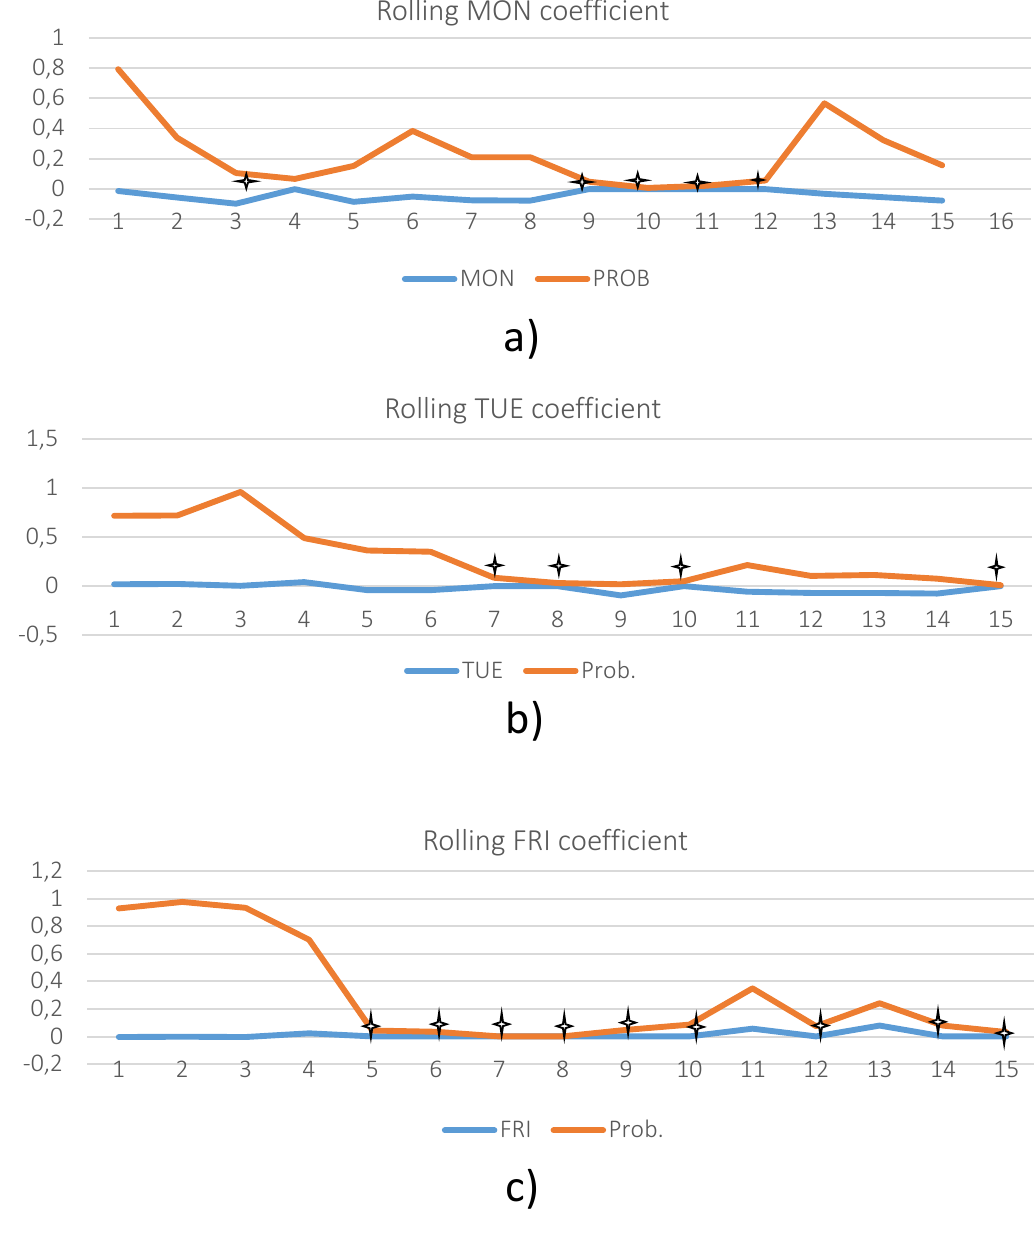
Figure 1. Time-varying day-of-the-week